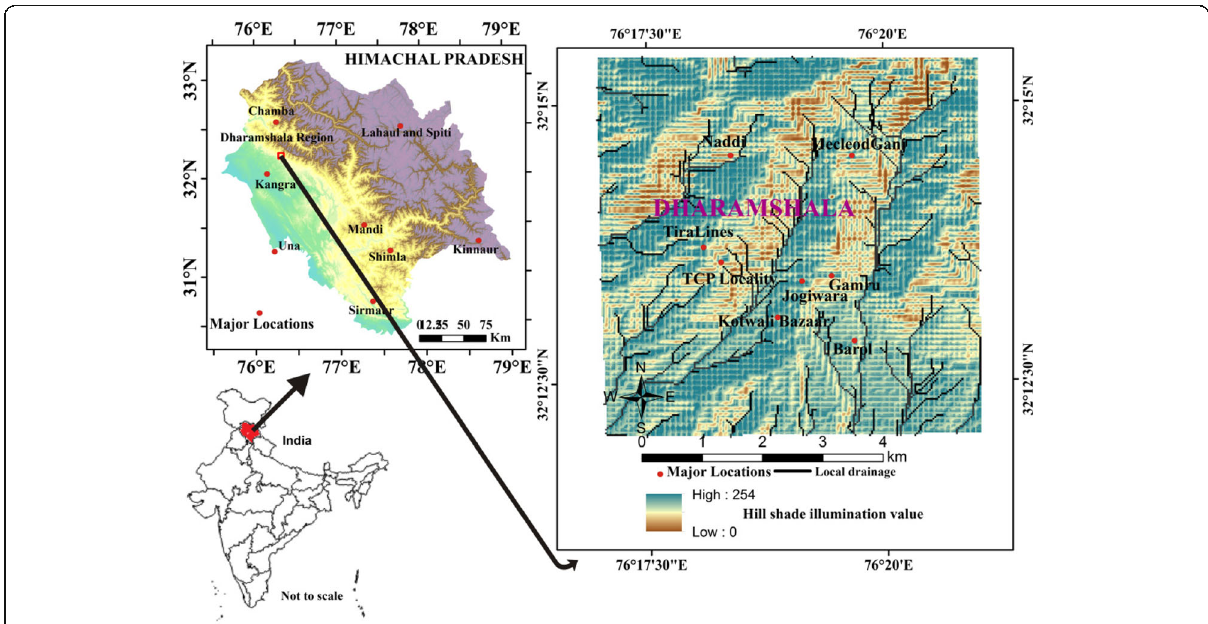
Fig. 1 Location map of the study area shown as hill shade view with local drainages and some of the major